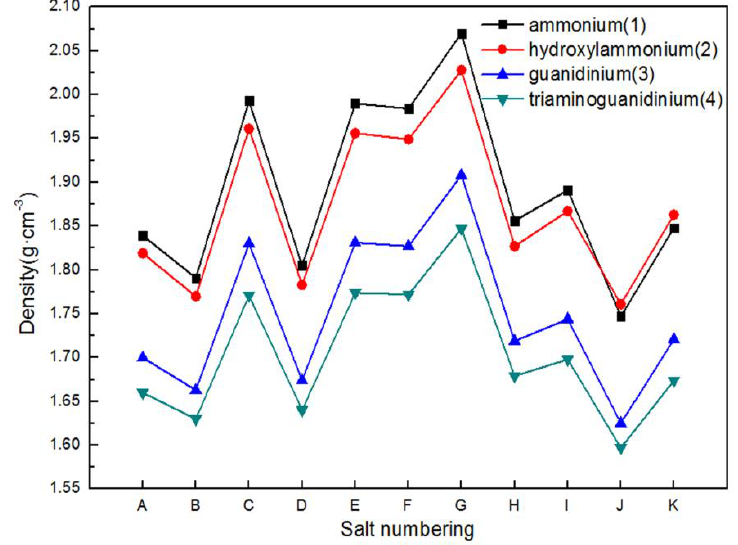
Figure 2. Comparison of the densities of ammonium-based 4,8-dihydrodifurazano[3,4- b , e ]pyrazine-based salts.